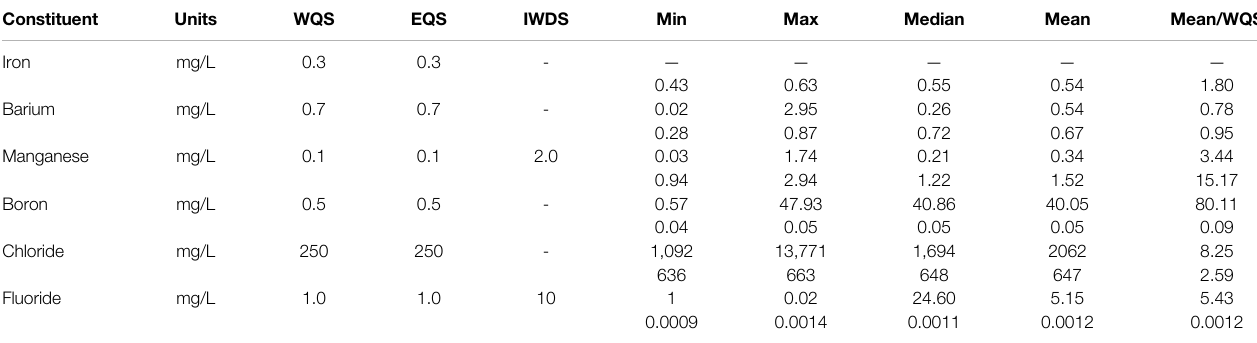
TABLE 2 | Concentrations of inorganic chemicals in fl owback water of the Junggar Basin. Highlighted rows indicate Mean/WQS ratio > 1. WQS is the Water Quality Standards for drinking water from China ’ s sanitary (GB 5749 – 2006), EQS is the Environmental Quality Standards for Surface Water (GB3838 – 2002), and IWDS is the Integrated Wastewater discharge standard of China (GB 8978 – 1996). The cells with dark background represent conventional T 2 k fl owback, and the corresponding cells represent unconventional P 2 l fl owback